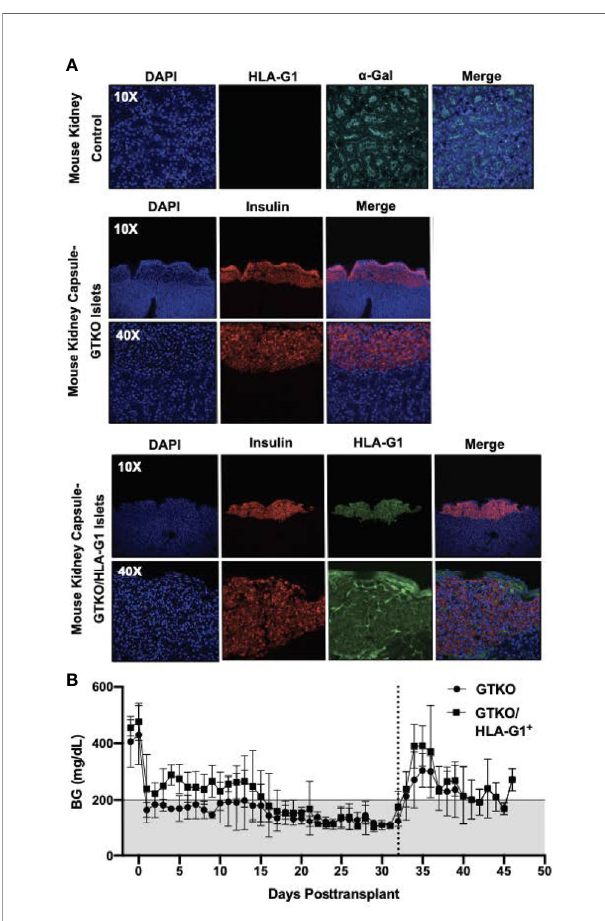
FIGURE 4 | Kidney capsule islet transplantation characterization. (A) Mouse kidneys were paraf fi n embedded, sectioned and labelled with Isolectin GS-IB 4 AF 647 Conjugate (Life Technologies; I32450), Mouse HLA-G monoclonal Antibody [87G] (Invitrogen; MA1-10356) tagged to Goat anti-mouse IgG AF 555 (Invitrogen; A32727) and DAPI as a control. The kidneys with the islet graft were labelled with Polyclonal Guinea Pig Anti-insulin (Dako; A0564) tagged to Donkey Anti-guinea pig IgG (H+L) AF 647 (Jackson Immuno Research; 706- 606-148), Mouse HLA-G monoclonal Antibody [87G] (Invitrogen; MA1-10356) and tagged to Goat anti-mouse IgG AF 555 (Invitrogen; A32727). DAPI was used to label nuclei of all cells. Isolectin GS-IB 4 was not used to avoid non- speci fi c excitation. All sections were imaged using the 10X, 20X and 40X objective on Olympus Fluoview 3000 inverted confocal microscope. (B) GTKO or GTKO/HLA-G1 islets were transplanted under the kidney capsule of STZ- diabetic nude mice. Blood glucose measurements through Day 32 were used to determine